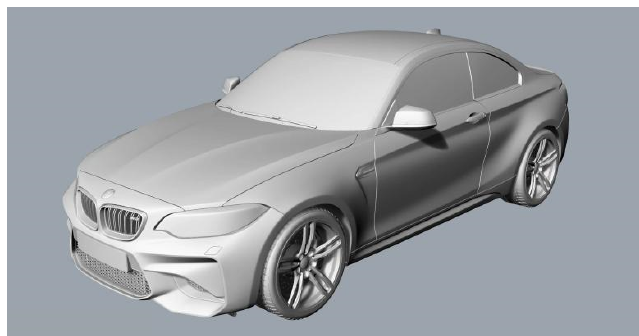
Figure 7. Experimental vehicle model. Table 3. Key parameters of the experimental vehicle model.